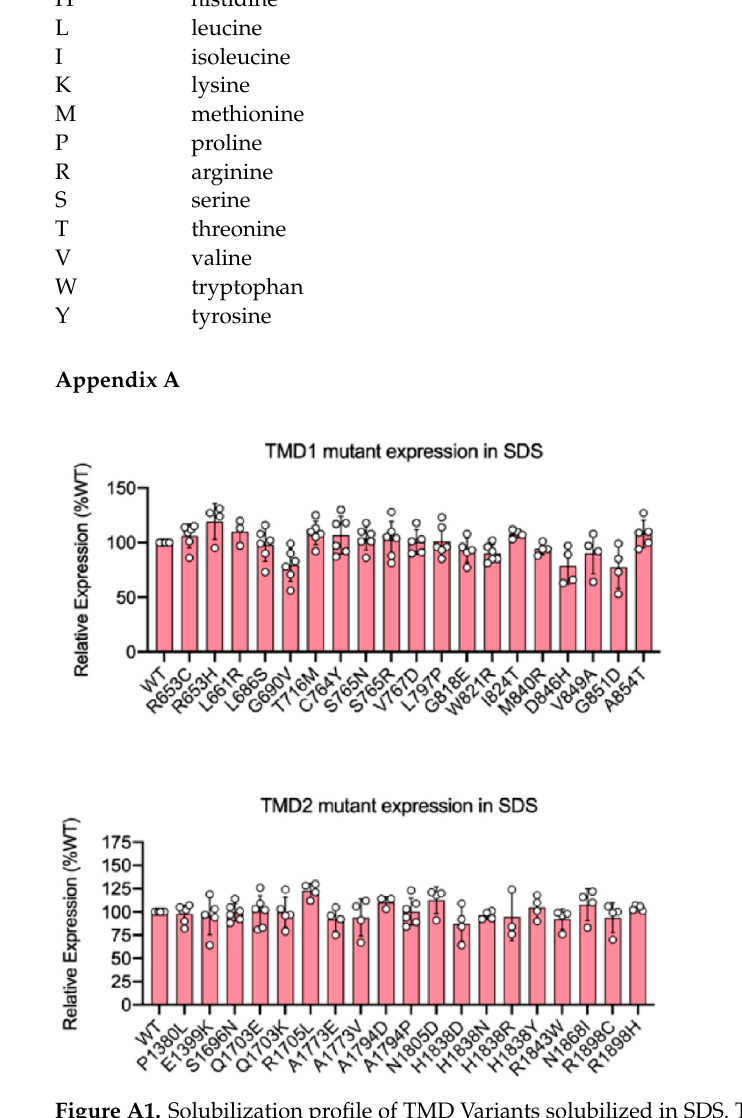
Figure A1. Solubilization profile of TMD Variants solubilized in SDS. The TMD1 and TMD2 variants were expressed in HEK293T cells and subsequently solubilized in SDS buffer for analysis on Western blots labeled for ABCA4 following SDS gel electrophoresis. Data is the mean ± SD for the indicated number of experiments. The majority of the variants expressed at within 80% of WT levels.